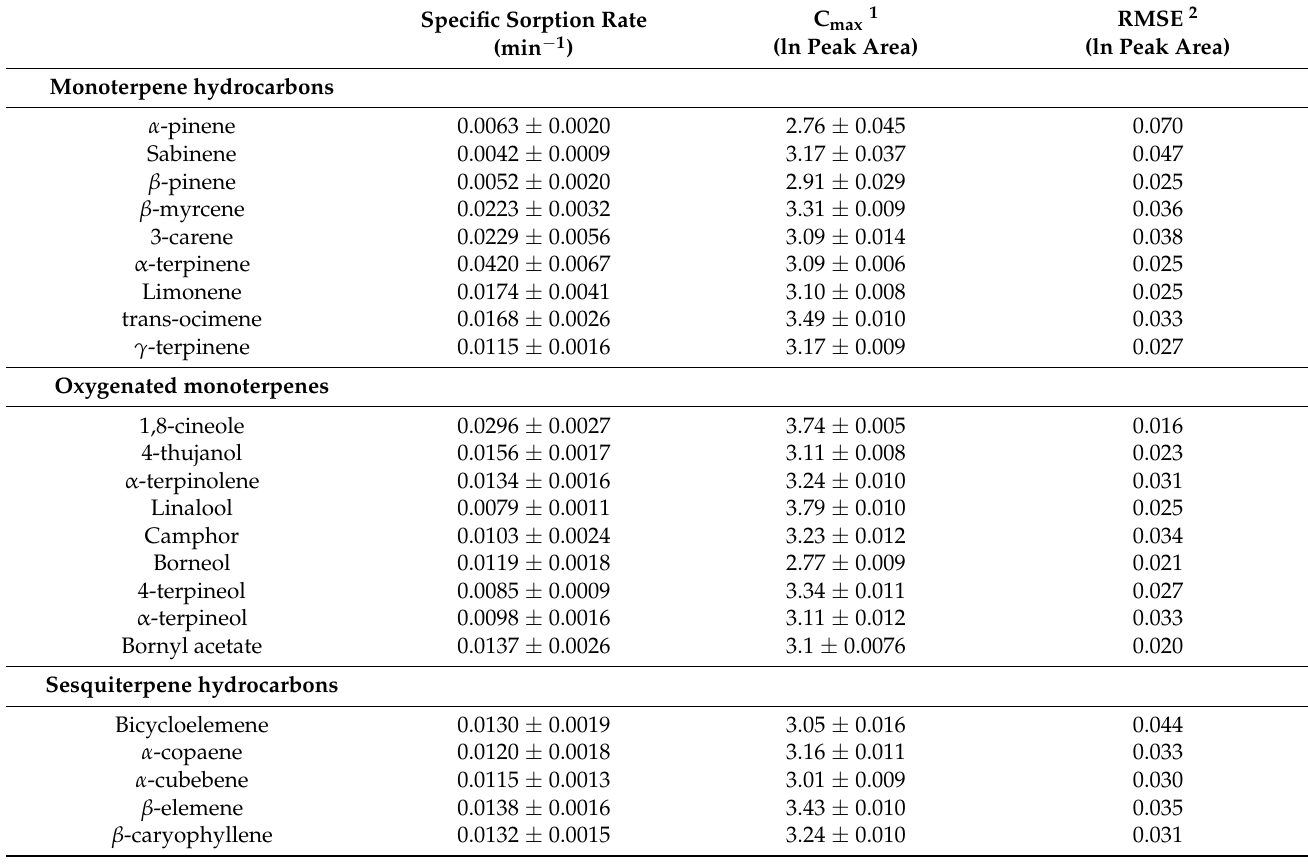
Figure 4. Volatile organic compounds sorption of fresh basil by SPME. Experimental data (symbols) were fitted (lines) with the Baranyi model (described by Equation (1)). Table 2. Headspace solid-phase microextraction sorption model